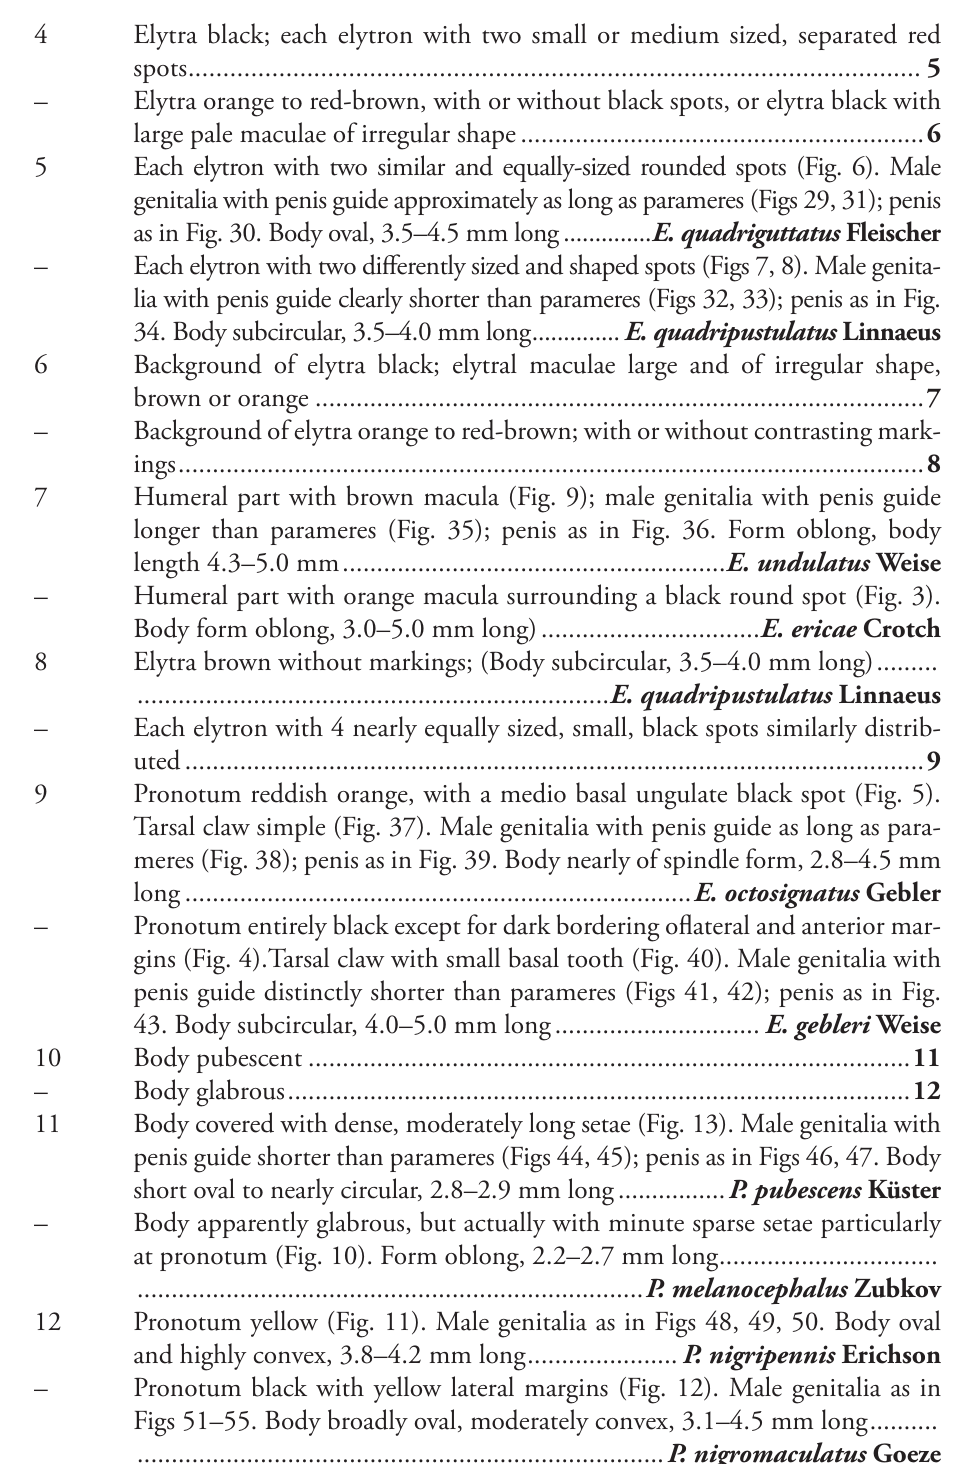
Elytra black; each elytron with two small or medium sized, separated red spots ......................................................................................................... 5 – Elytra orange to red-brown, with or without black spots, or elytra black with large pale maculae of irregular shape ........................................................... 6 5 Each elytron with two similar and equally-sized rounded spots (Fig. 6). Male genitalia with penis guide approximately as long as parameres (Figs 29, 31); penis as in Fig. 30. Body oval, 3.5–4.5 mm long .............. E. quadriguttatus Fleischer – Each elytron with two differently sized and shaped spots (Figs 7, 8). Male genita- lia with penis guide clearly shorter than parameres (Figs 32, 33); penis as in Fig. 34. Body subcircular, 3.5–4.0 mm long .............. E. quadripustulatus Linnaeus 6 Background of elytra black; elytral maculae large and of irregular shape, brown or orange ......................................................................................... 7 – Background of elytra orange to red-brown; with or without contrasting mark- ings ............................................................................................................. 8 7 Humeral part with brown macula (Fig. 9); male genitalia with penis guide longer than parameres (Fig. 35); penis as in Fig. 36. Form oblong, body length 4.3–5.0 mm ........................................................ E. undulatus Weise – Humeral part with orange macula surrounding a black round spot (Fig. 3). Body form oblong, 3.0–5.0 mm long) ................................ E. ericae Crotch 8 Elytra brown without markings; (Body subcircular, 3.5–4.0 mm long) ......... ..................................................................... E. quadripustulatus Linnaeus – Each elytron with 4 nearly equally sized, small, black spots similarly distrib- uted ............................................................................................................ 9 9 Pronotum reddish orange, with a medio basal ungulate black spot (Fig. 5). Tarsal claw simple (Fig. 37). Male genitalia with penis guide as long as para- meres (Fig. 38); penis as in Fig. 39. Body nearly of spindle form, 2.8–4.5 mm long .......................................................................... E. octosignatus Gebler – Pronotum entirely black except for dark bordering oflateral and anterior mar- gins (Fig. 4).Tarsal claw with small basal tooth (Fig. 40). Male genitalia with penis guide distinctly shorter than parameres (Figs 41, 42); penis as in Fig. 43. Body subcircular, 4.0–5.0 mm long .............................. E. gebleri Weise 10 Body pubescent ........................................................................................ 11 – Body glabrous ........................................................................................... 12 11 Body covered with dense, moderately long setae (Fig. 13). Male genitalia with penis guide shorter than parameres (Figs 44, 45); penis as in Figs 46, 47. Body short oval to nearly circular, 2.8–2.9 mm long ................ P. pubescens Küster – Body apparently glabrous, but actually with minute sparse setae particularly at pronotum (Fig. 10). Form oblong, 2.2–2.7 mm long ................................ .......................................................................... P. melanocephalus Zubkov 12 Pronotum yellow (Fig. 11). Male genitalia as in Figs 48, 49, 50. Body oval and highly convex, 3.8–4.2 mm long ...................... P. nigripennis Erichson – Pronotum black with yellow lateral margins (Fig. 12). Male genitalia as in Figs 51–55. Body broadly oval, moderately convex, 3.1–4.5 mm long .......... ............................................................................. P. nigromaculatus